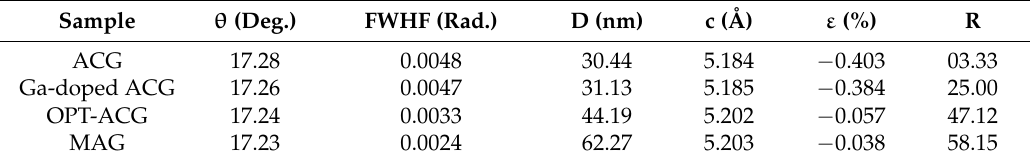
Figure 3. XRD patterns of ZNRs grown with ( a ) ACG, ( b ) Ga-doped ACG, ( c ) OPT-ACG, and ( d ) MAG methods. Table 1. Structural and optical parameters of all the samples.